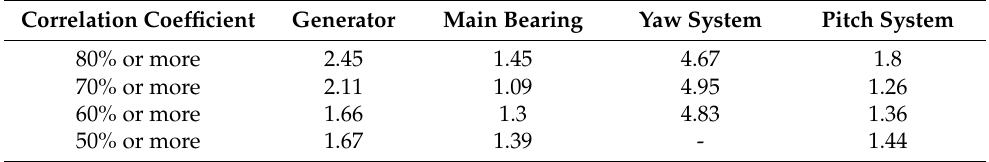
Table 3. Training accuracy results of the SCADA data.